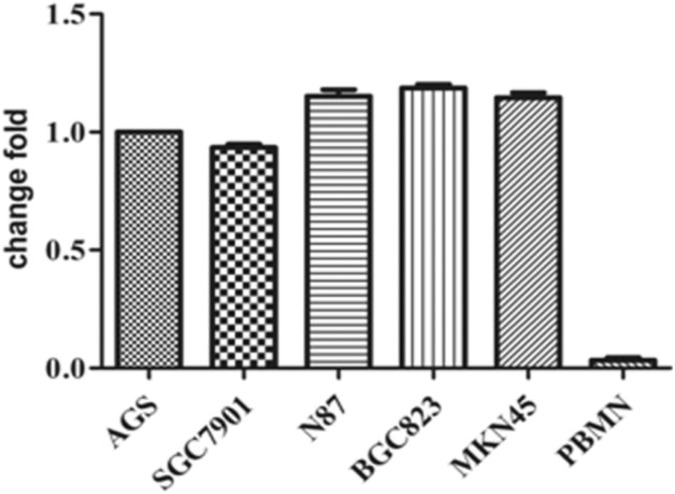
CK20 mRNA is expressed in multiple GC cell lines. There was no significant difference
in CK20 expression among the 5 cell lines examined (t = 1.734,
P = .181). CK20 indicates cytokeratin 20; mRNA, messenger RNA.